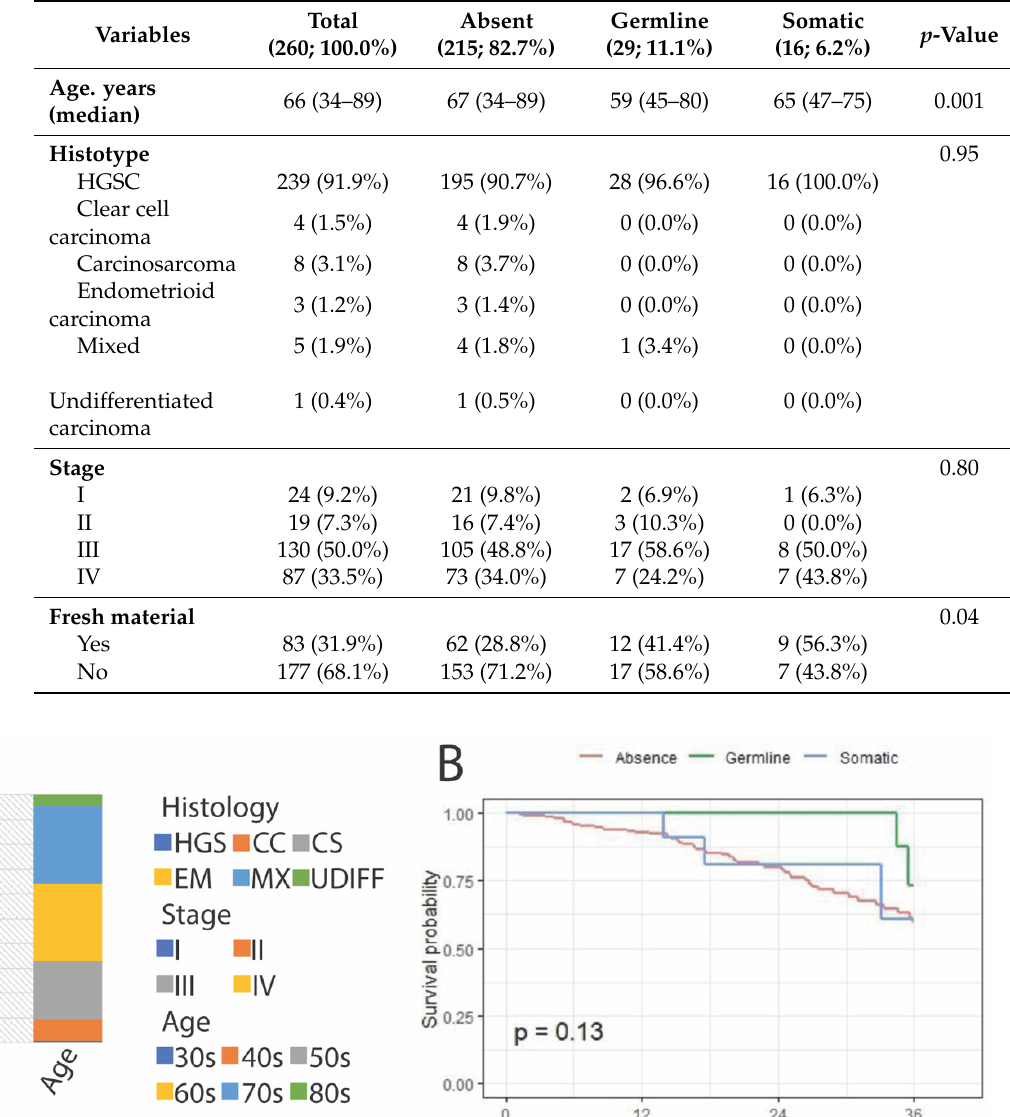
Table 1. Clinicopathologic characteristics of the study cohort, as related to the detected BRCA1/2 status. The clinicopathologic characteristics of the study cohort, for all of the patients, as well as for the patients with somatic, germline or no (i.e., “absent”) BRCA1/2 variants. Note that 14 patients with tumour detected variants did not undergo follow-up germline testing and are not included in this table. The p-value indicates that when considering a level of statistical significance of 5%, there is evidence to say that the groups absence, germline, and somatic differ in age.